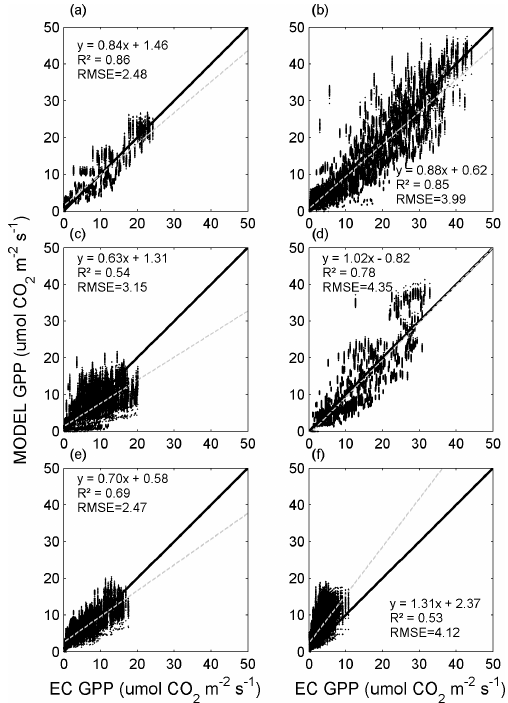
Figure 7. Evaluation of the modelled gross primary production (GPP; Eq. 13) against in situ GPP for the six sites across the Sahel (Fig. 1). The thick black lines show the one-to-one ratios, whereas the dotted thin grey lines are the fitted ordinary least square regres- sions. The sites are (a) Agoufou (ML-AgG), (b) Dahra (SN-Dah), (c) Demokeya (SD-Dem), (d) Kelma (ML-Kem), (e) Wankama Fal- low (NE-WaF) and (f) Wankama Millet (NE-WaM).